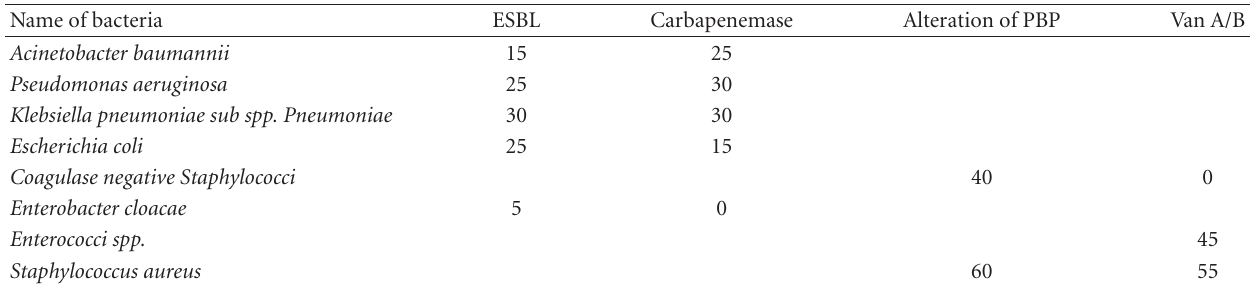
Table 4: Di ff erent mechanisms of drug resistance in isolates of indwelling medical